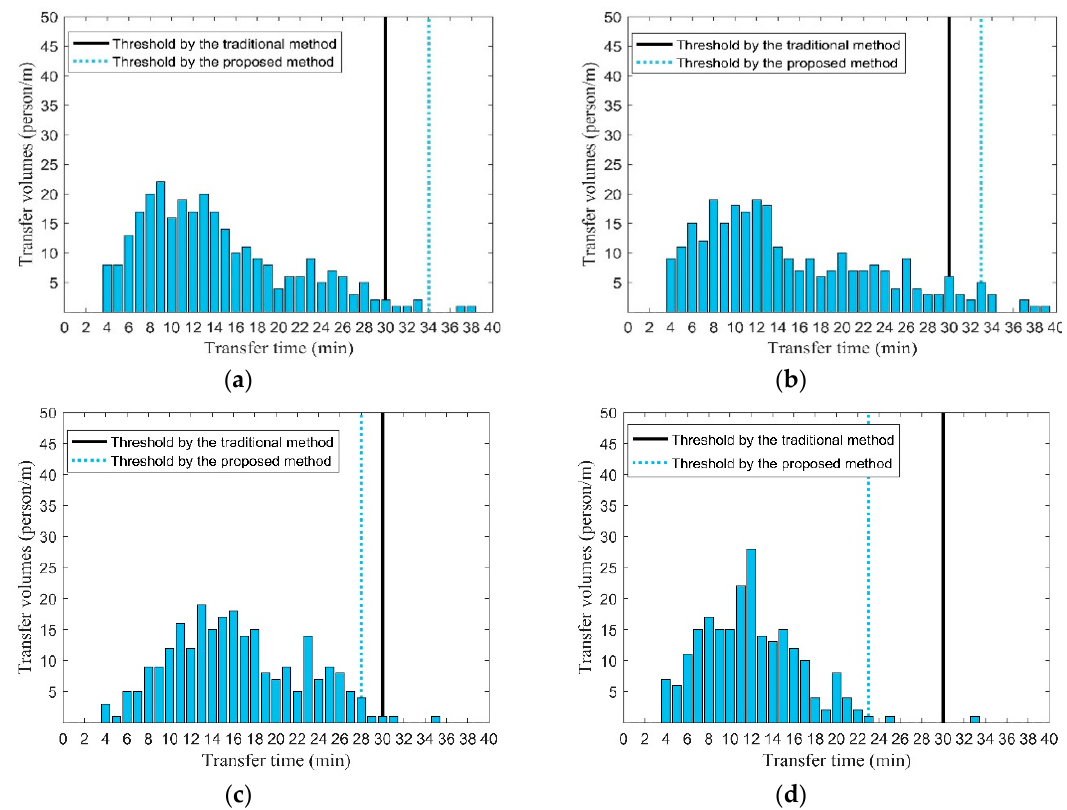
Figure 9. Comparison of two metro-to-bus transfer identification methods at four stations at 18:00–20:00 on 23–24 March. ( a ) Guomao station. ( b ) Shenzhen university station. ( c ) Daxin station. ( d ) Airport east station.